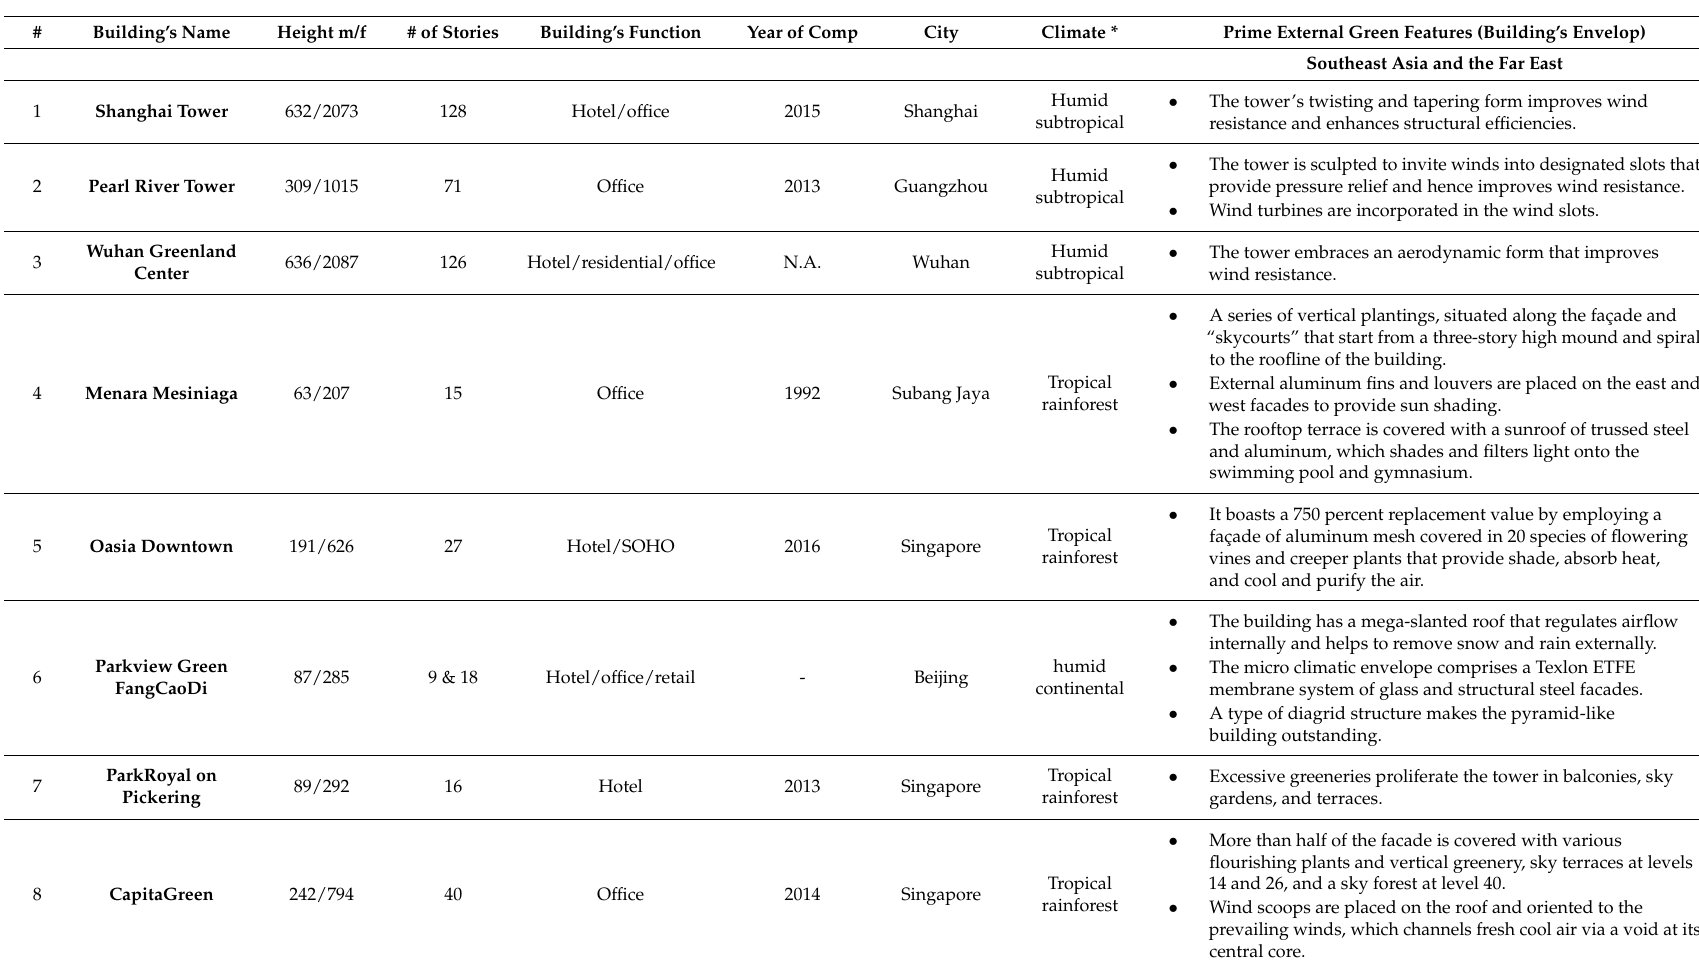
Table 1. Summary of Applied Sustainable Design